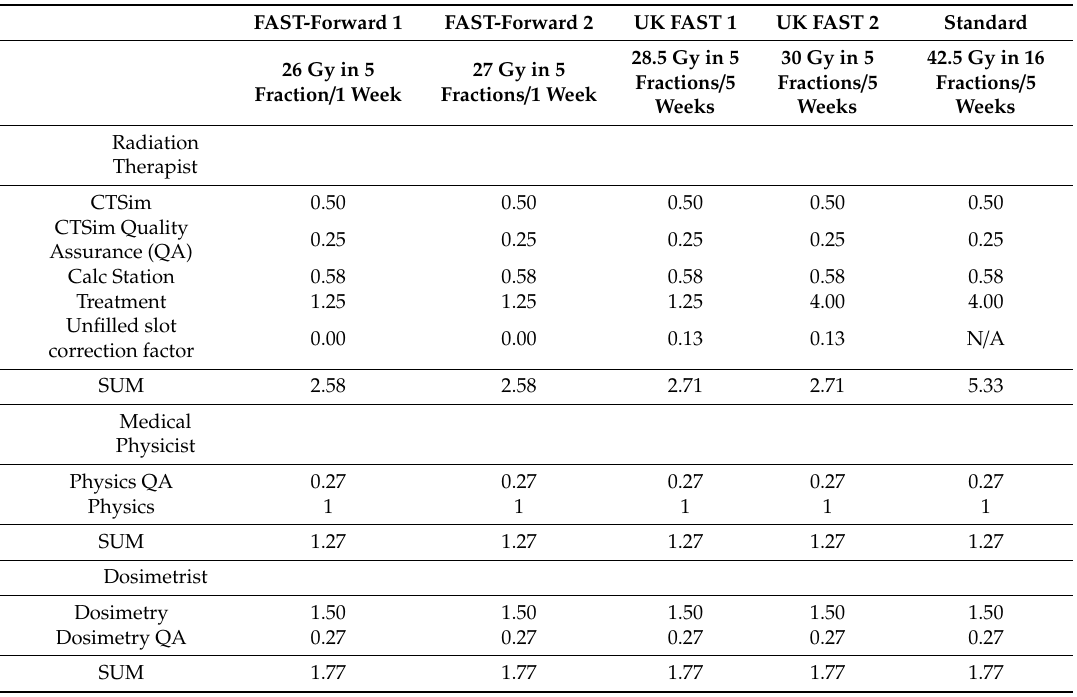
Table 1. Summary of human resources required in hours per patient per treatment course.